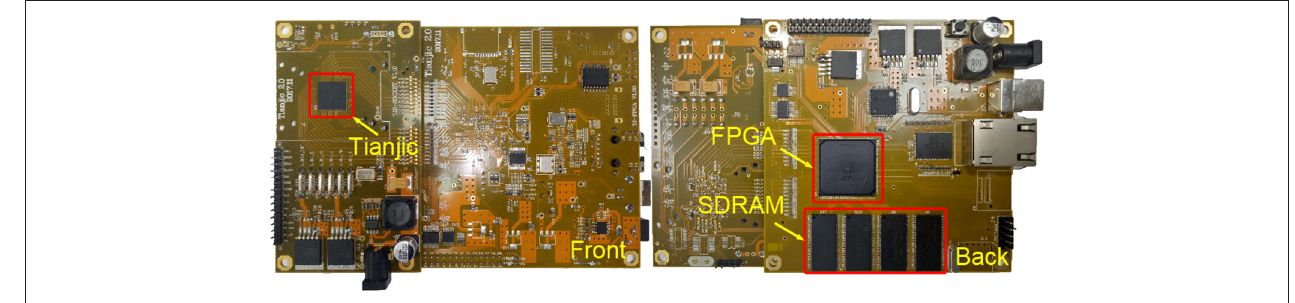
FIGURE 7 | Single-chip PCB.